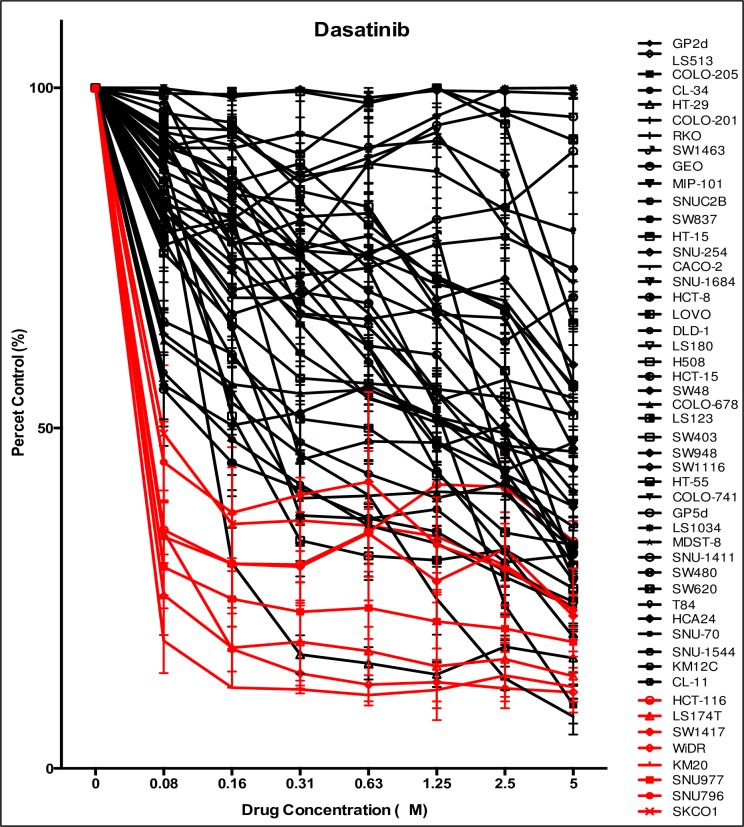
The effects of dasatinib on CRC cell lines in vitro.Fifty CRC cell lines were treated with dasatinib (dose 0.08–5 μmol/L) and proliferation was determined by an SRB assay. An IC50 ≤ 0.08 μM were deemed sensitive to dasatinib. The CRC cell lines KM20, LS174T, SNU-977, WiDR, HCT-116, SW1417, SNU-796, and SKCO1 demonstrated sensitivity to dasatinib.